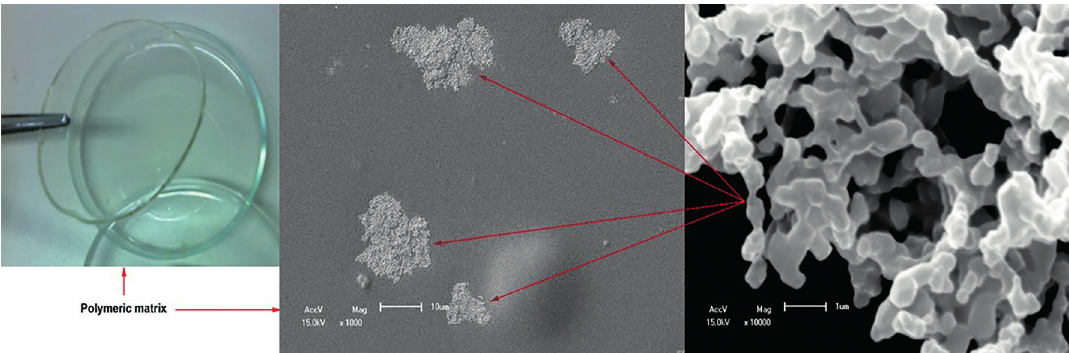
Figure 6. SEM images of hydroxyapatite fiber embedded in polymeric matrix. Figure 7c and 7d shows the FESEM images of the ZT- comparative analysis with the standard ruler. Nanowires are nws, where one can observed that ZrTiO nanowires were distributed in the substrate and show a mean aspect ratio (l/d) 4 formed with a reasonable level of organization, producing of approximately 30, the visual example show the diameter high density regions of ZT-nws. Nanowires diameter (d) and in nanometer length (l) were measured in electron microscopy images by